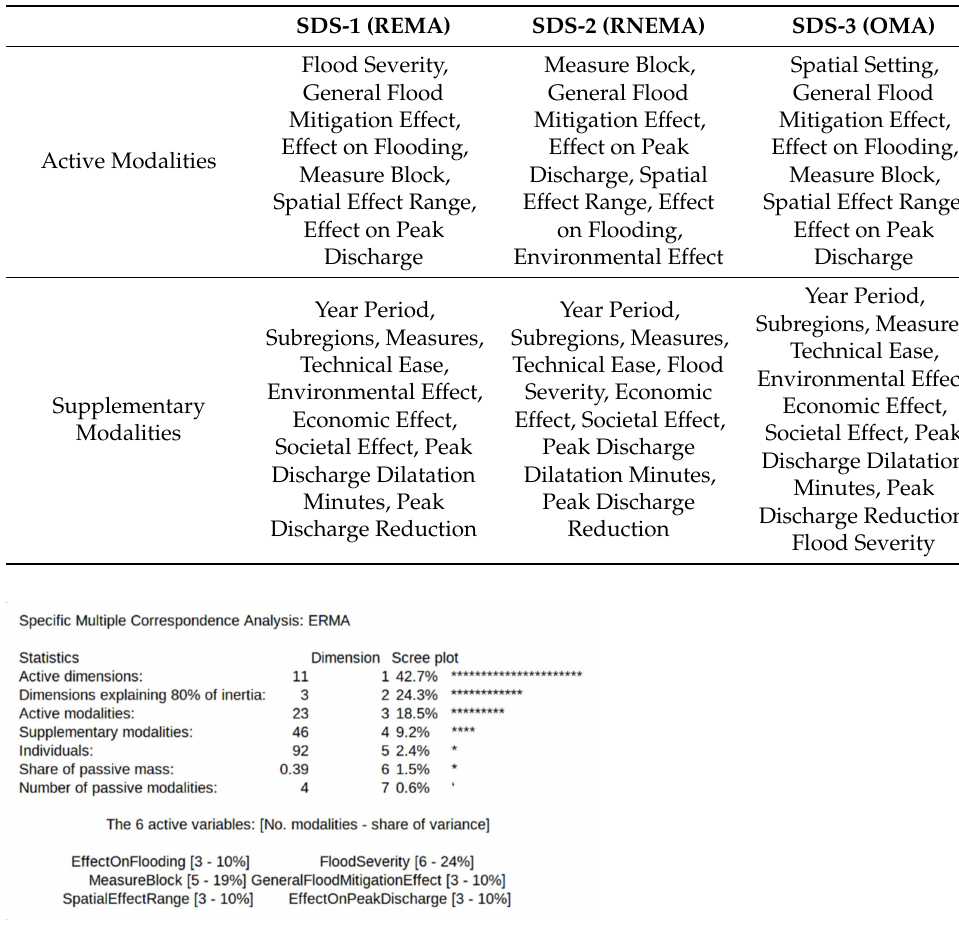
Figure A1. MCA model of rural European mountainous areas (sub-data set